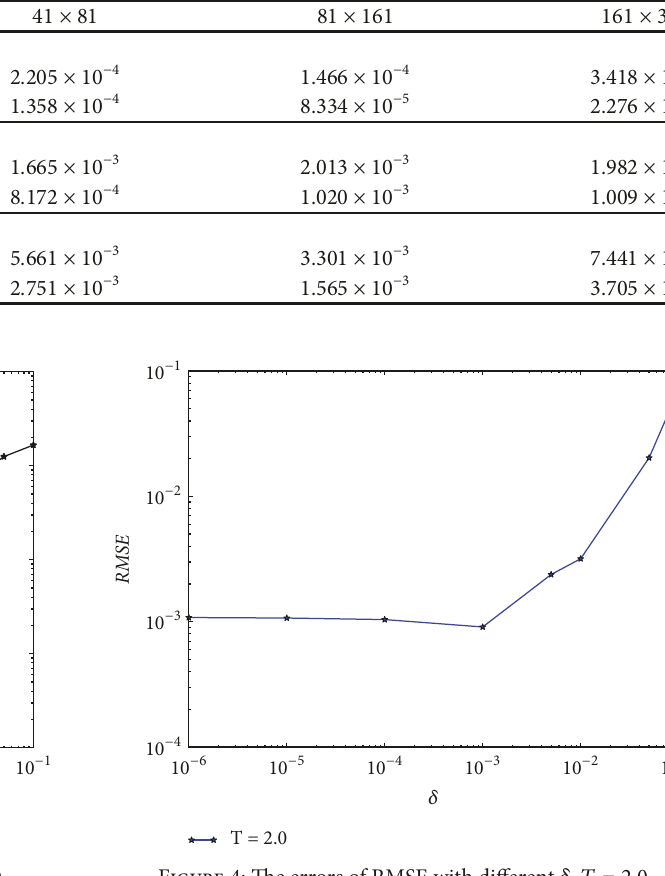
Table 2: Maxerror and RMSE for 𝑇 = 1.0,2.0,3.0 with different grids.